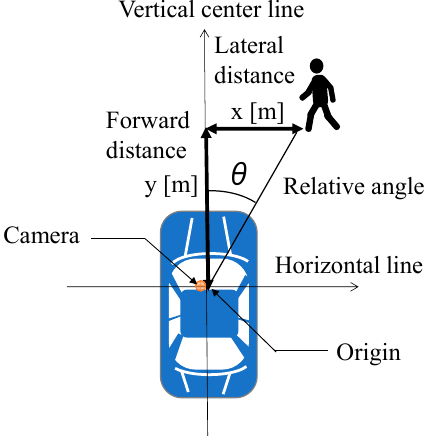
Figure 2. Relative position of a pedestrian from an ego vehicle.